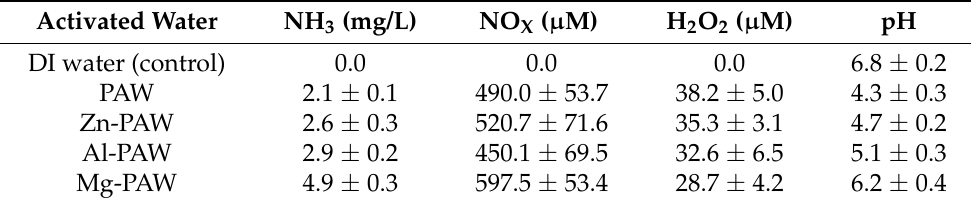
Table 1. Physicochemical properties of DI water, PAW, PAW with Zn (Zn-PAW), PAW with Al (Al-PAW), and PAW with Mg